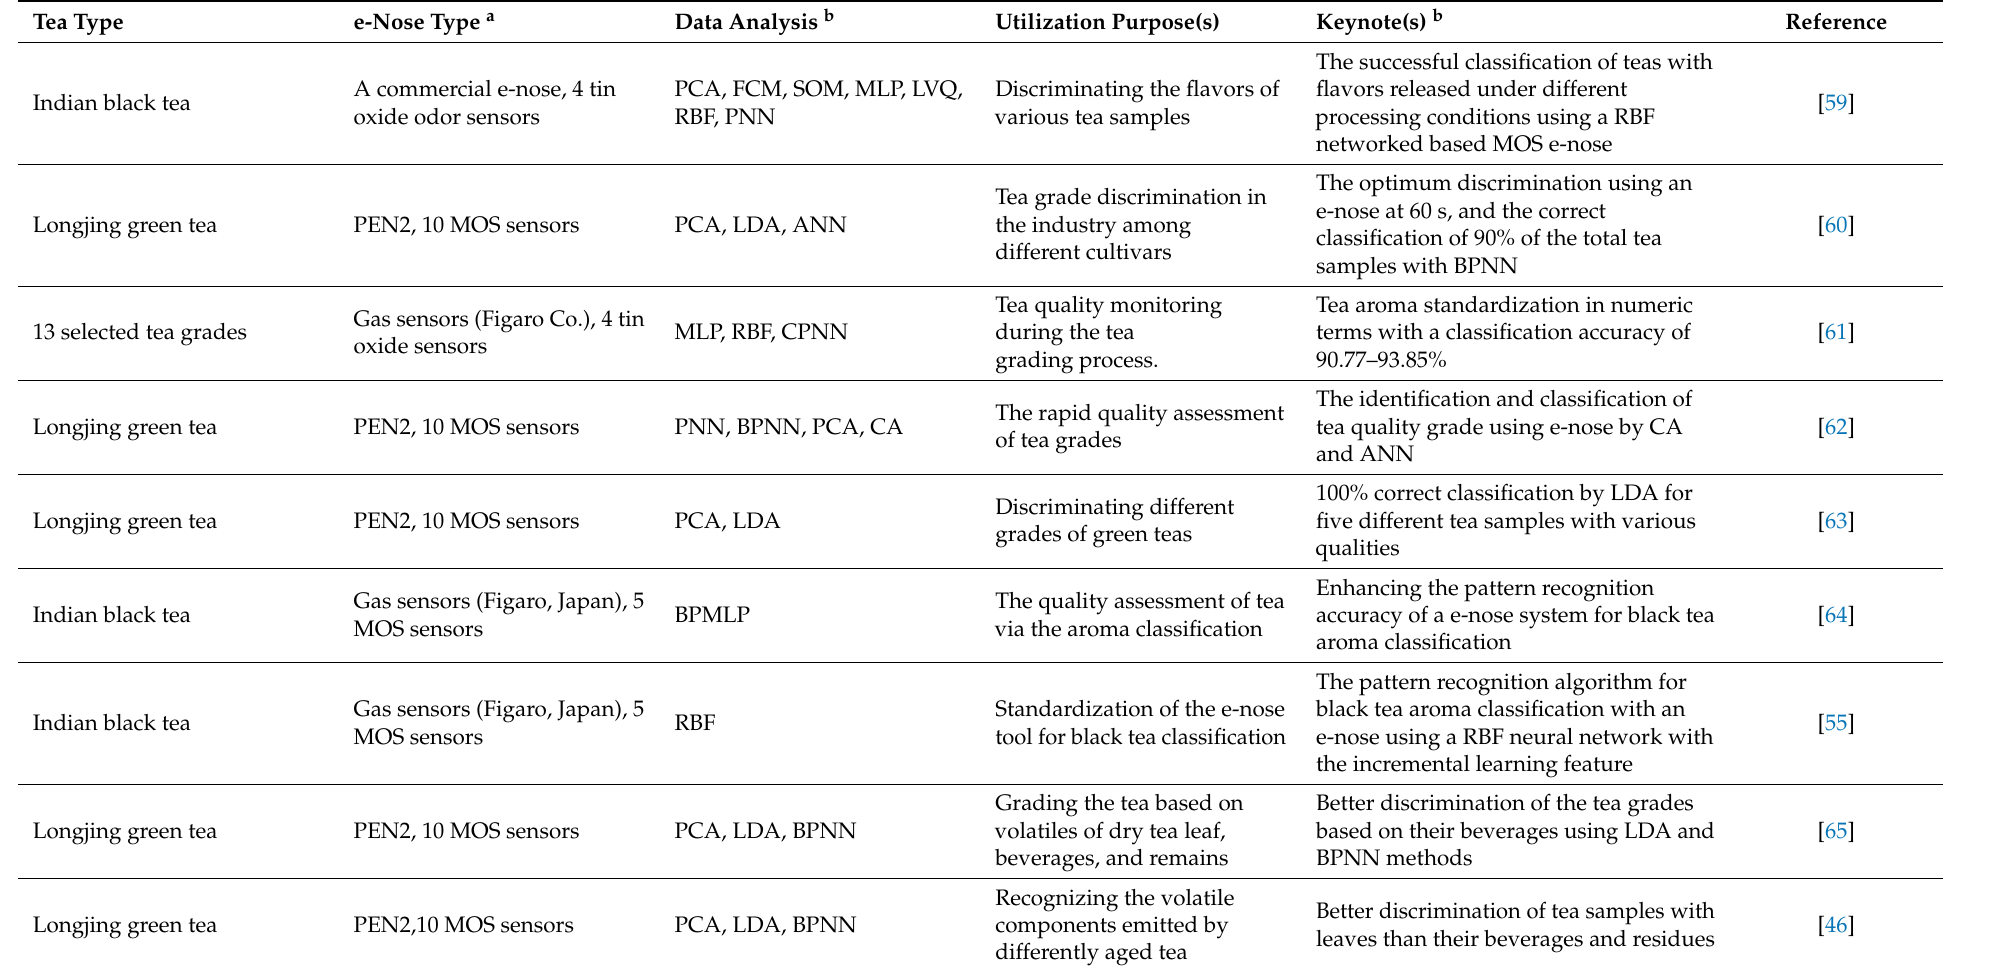
Table 1. A summary of e-nose technologies used to monitor the quality parameters of different teas and their